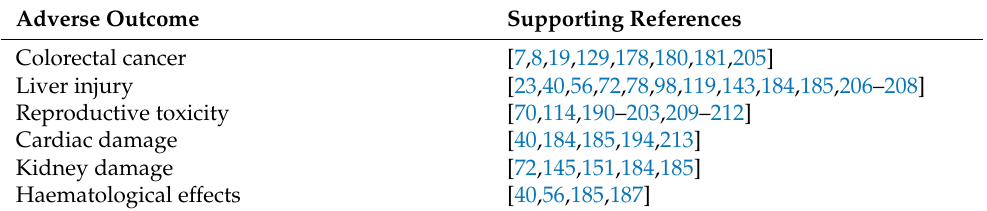
Table 3. Probable adverse outcomes of ingested TiO 2 -NPs and selection of associated publications. Adverse